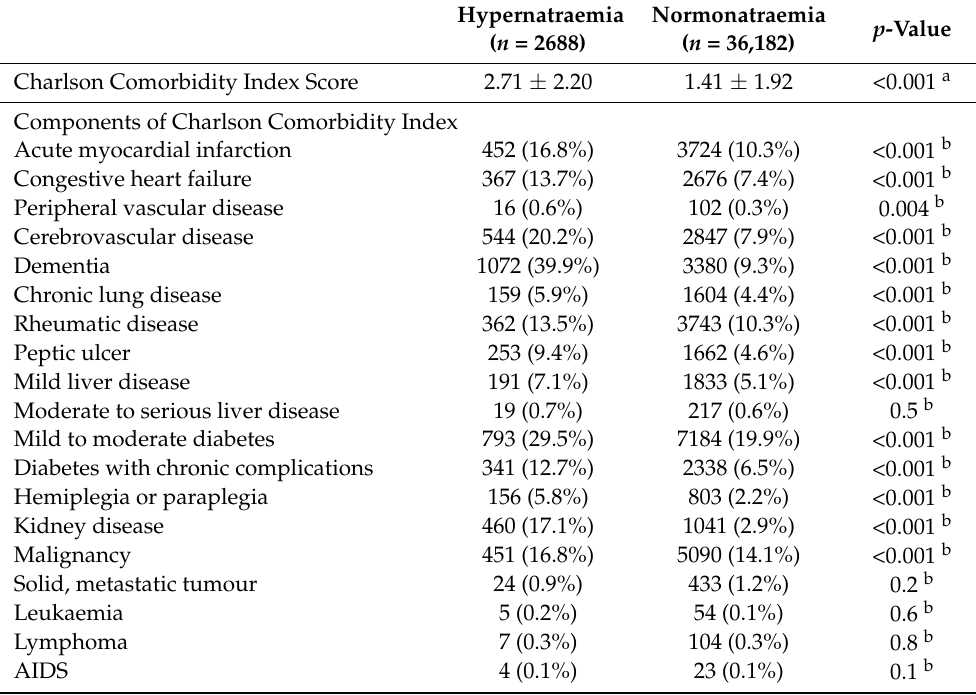
Table 5. Charlson Comorbidity Index and its components in COVID-19 patients with hypernatraemia or normonatraemia at